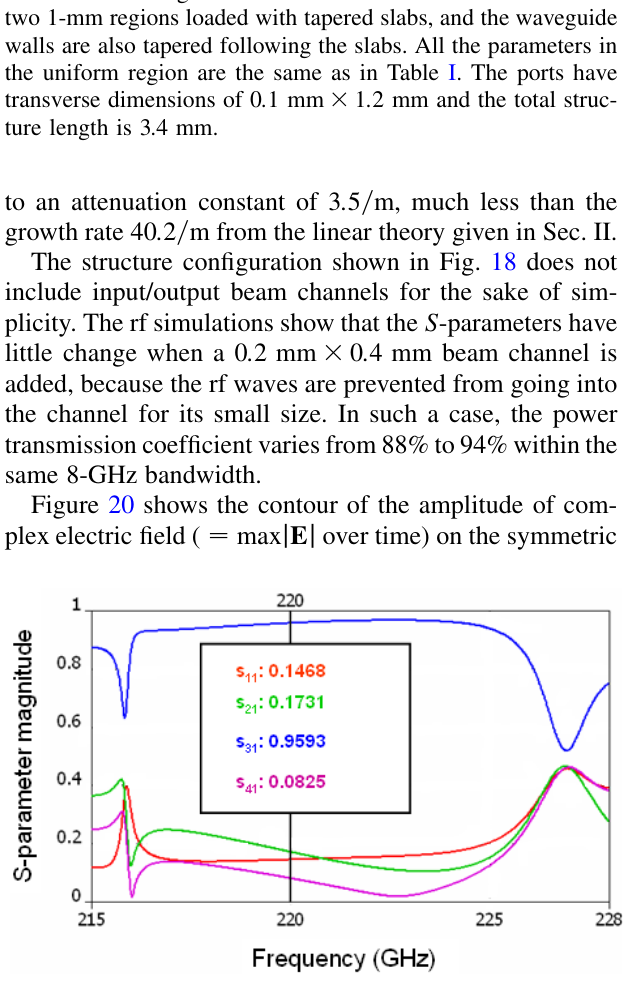
FIG. 19. (Color) S -parameters vs frequency for a 220-GHz TWT structure with input/output couplers. The power transmission coefficient is between 89% and 94% in a bandwidth of 8 GHz (217 GHz–225 GHz), and it is (cid:1) 93% at 220 GHz with a voltage standing-wave ratio of 1.34.